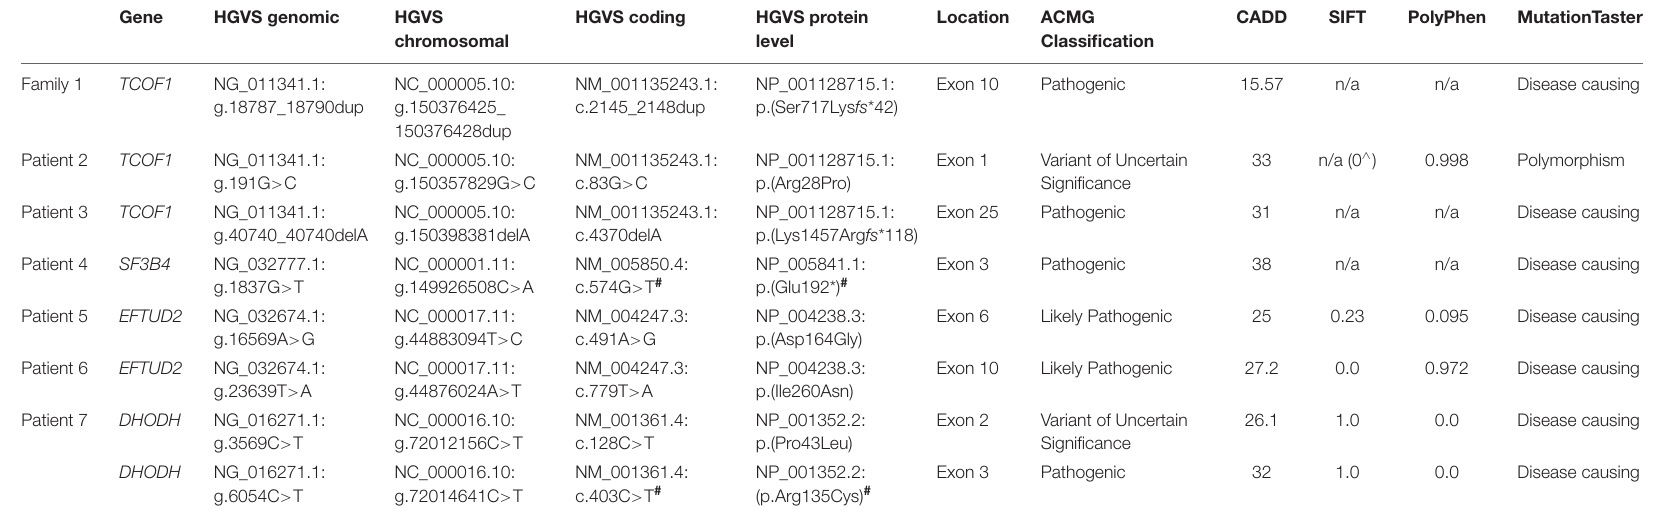
TABLE 2 | Summary of pathogenic variants reported in this